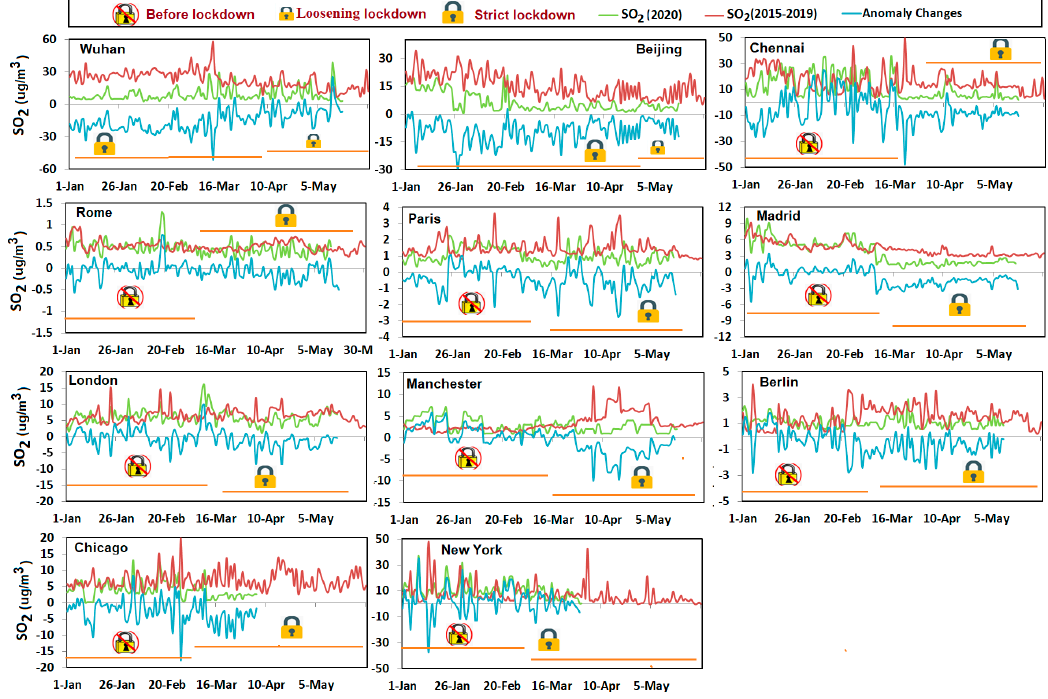
Figure 8. Daily mean SO 2 dataset and its anomaly changes compared to the baseline values in different global metropolitan cities in 2020 (i.e., average values of SO 2 from different ground-based monitoring stations on the same dates of 2015–2019).